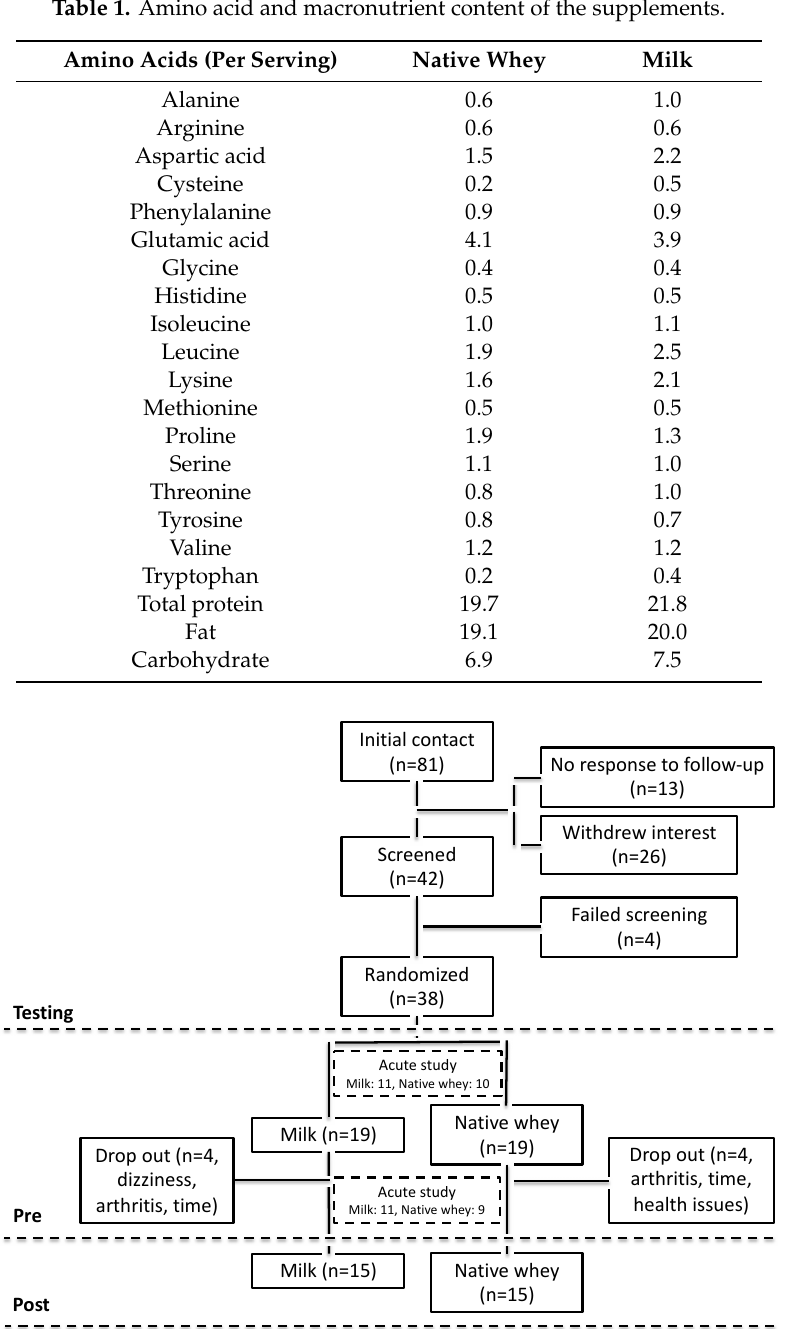
Figure 1. Flow chart diagram of study recruitment, enrollment, randomization follow-up, and analysis.